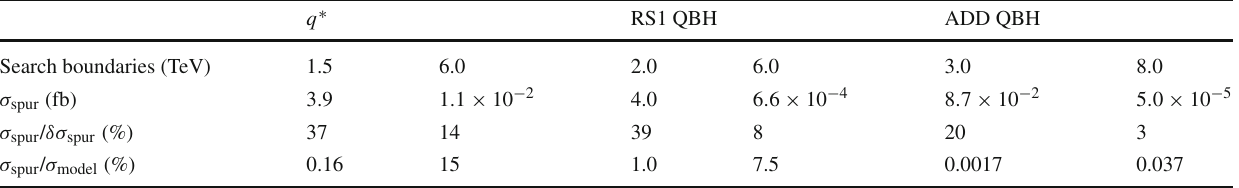
Table 3 Spurious-signal cross-sections ( σ spur ), and the ratio of the ues of these quantities are given at the boundaries of the search range spurious-signal cross-sections to their uncertainties ( δσ spur ) and to the reported in the first row signal cross-sections ( σ model ) for the three benchmark models. The val- q ∗ RS1